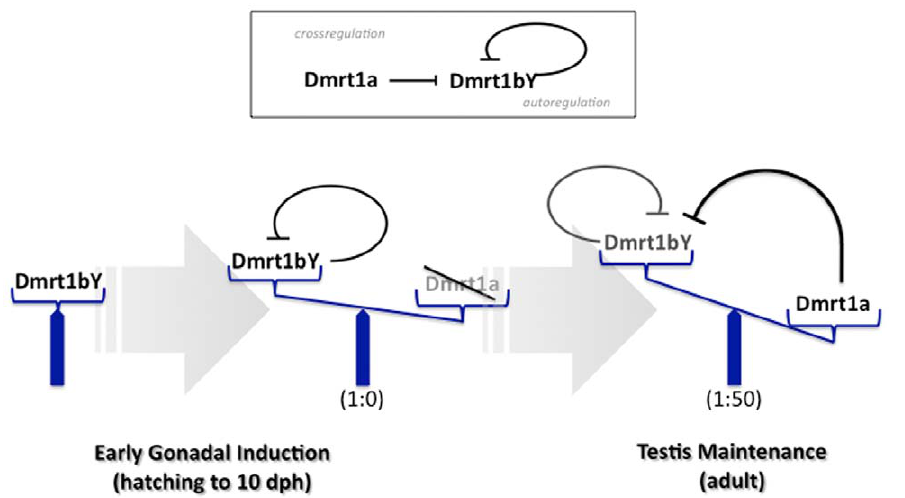
Figure 8. Model for feedback and cross-regulation of the medaka dmrt1 paralogs. During sex determination stages only dmrt1bY is expressed and dmrt1a is off. Hence, the sex determining function of dmrt1bY is exerted. In adult testes, both paralogs are expressed notably in Sertoli cells, but the autorepression of the dmrt1bY promoter by its own gene product and the cross-regulation by Dmrt1a lead to a predominant expression of dmrt1a compared to dmrt1bY (appox. 50